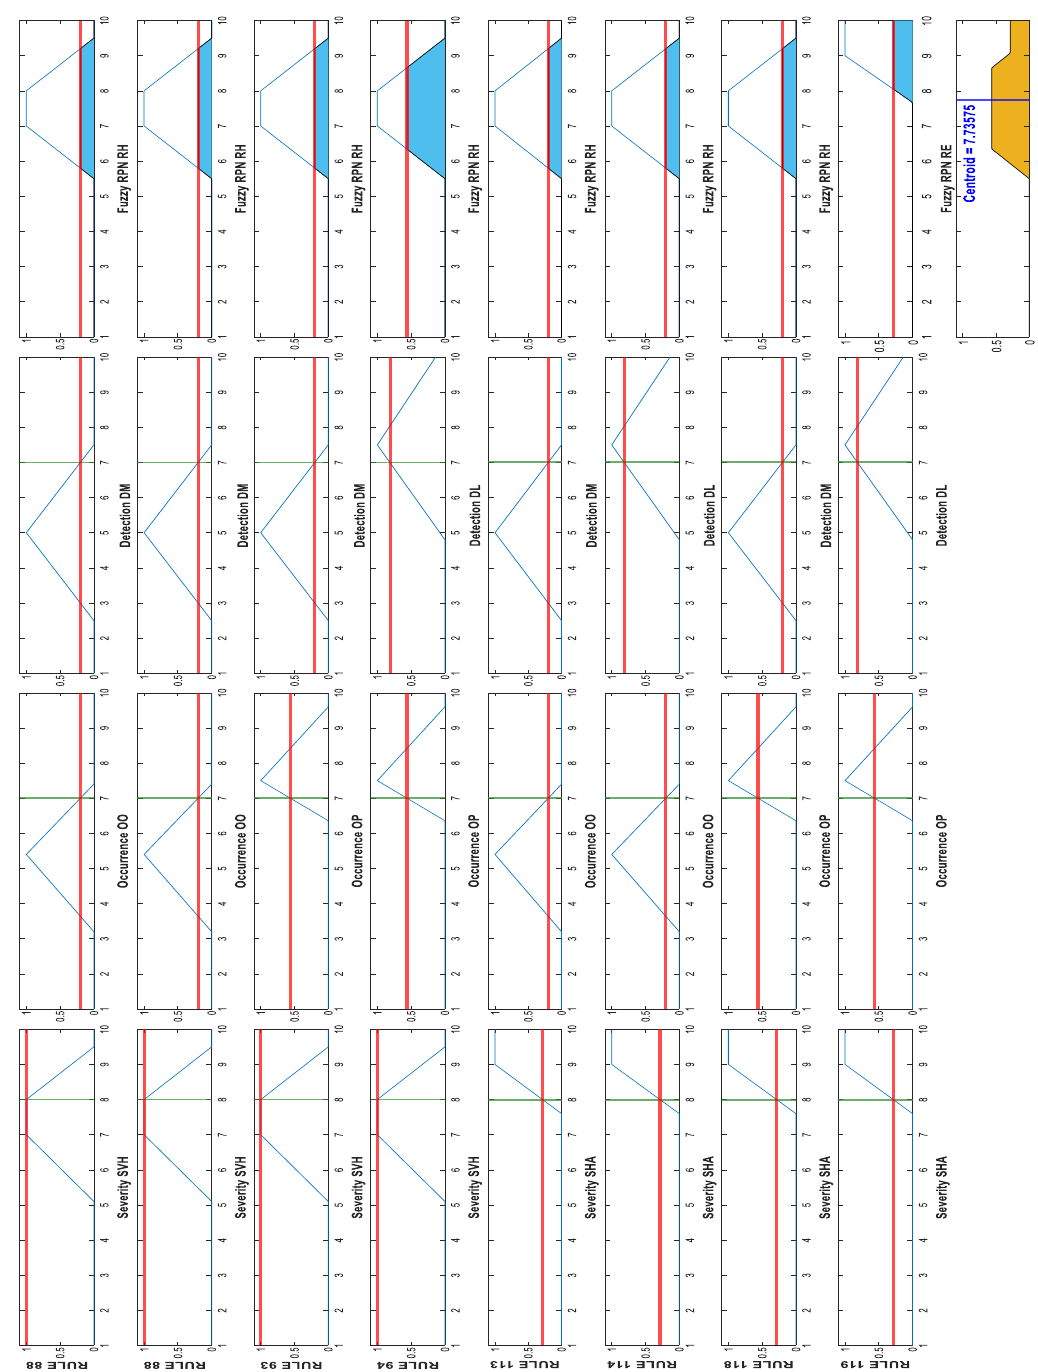
Figure 9. Fired fuzzy rules and associated fuzzy RPN (Centroid) for the FM38—IED control failure by defective data processing (“software error”).